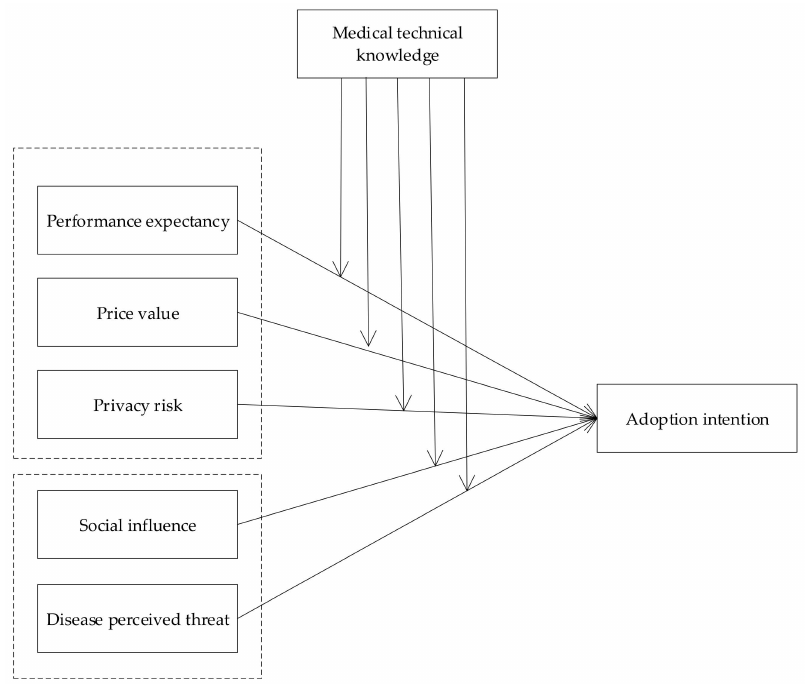
Figure 1. Conceptual